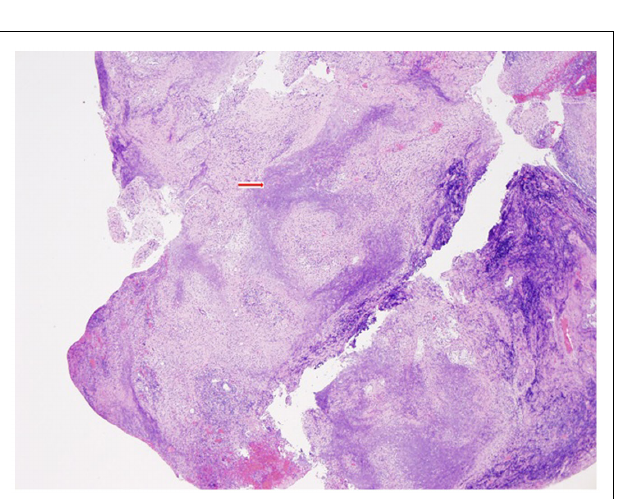
FIGURE 4 |At low magnification, the histologic features include ”geographic”type necrosis with a basophilic appearance in right nasal pharynx (H&E stain, 40 × ). Red arrow shows basophilic, “geographic” type necrosis.